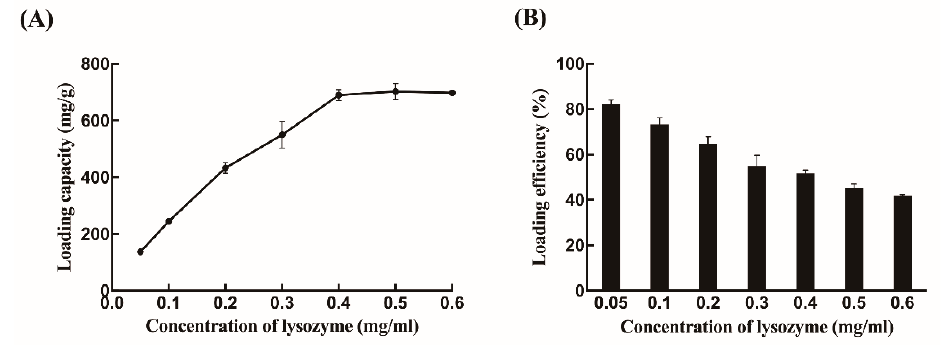
Figure 2. Analysis of lysozyme immobilized chitosan nanoparticles (Lys-CS-NPs): ( A ) lysozyme loading capacity of Lys-CS-NPs; and ( B ) lysozyme loading efficiency of Lys-CS-NPs.